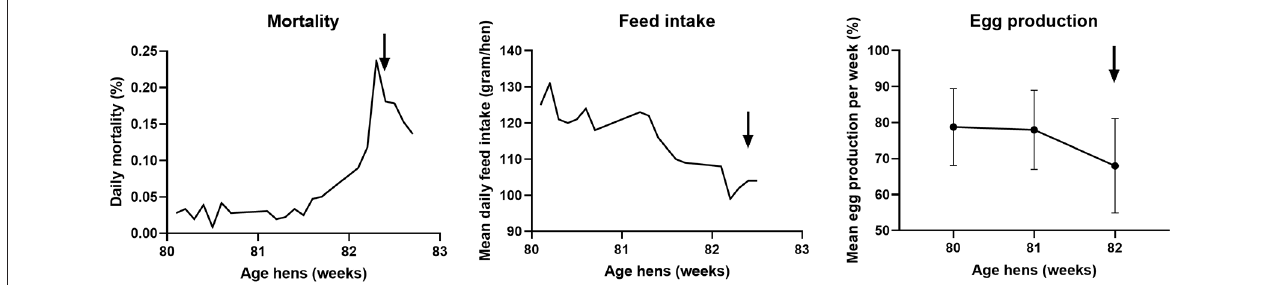
FIGURE 3 | Course of daily mortality, mean feed intake and mean egg production of the flock between 80 and 83 weeks of age at the free-range layer farm. Daily mortality is expressed as percentage of the total amount of hens present, the mean daily feed intake in gram per day per hen, and the mean egg production per week as a percentage of the total amount of hens present ± standard deviation. The arrow indicates the day of reporting the clinically suspect